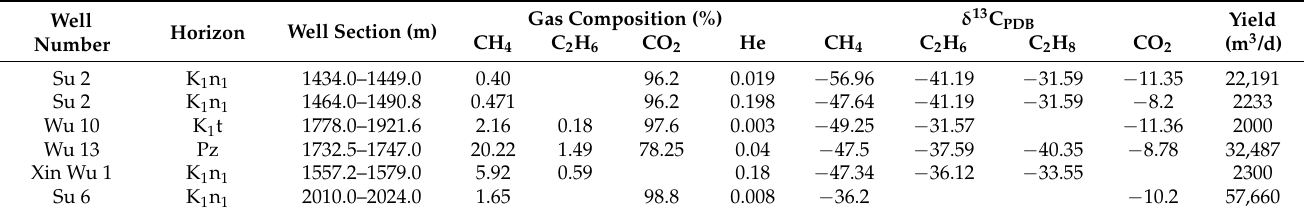
Table 1. Characteristics of natural gas composition in Hailar Basin.